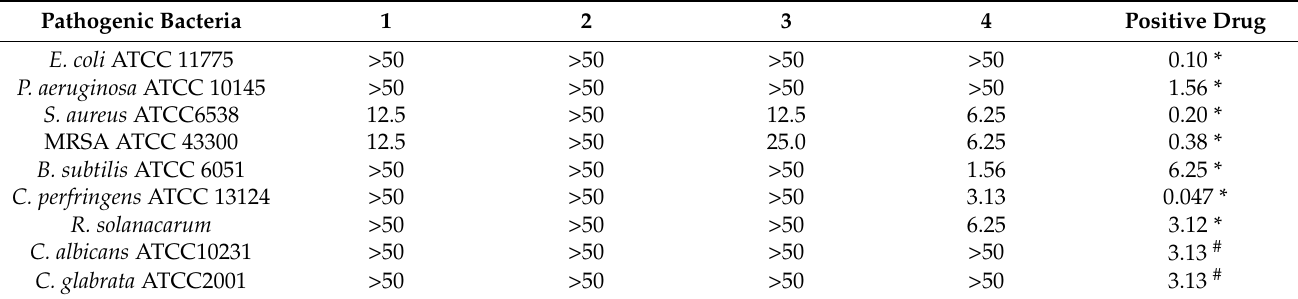
Table 2. Antimicrobial activity of 1 – 4 (MIC, µ M), n = 3.